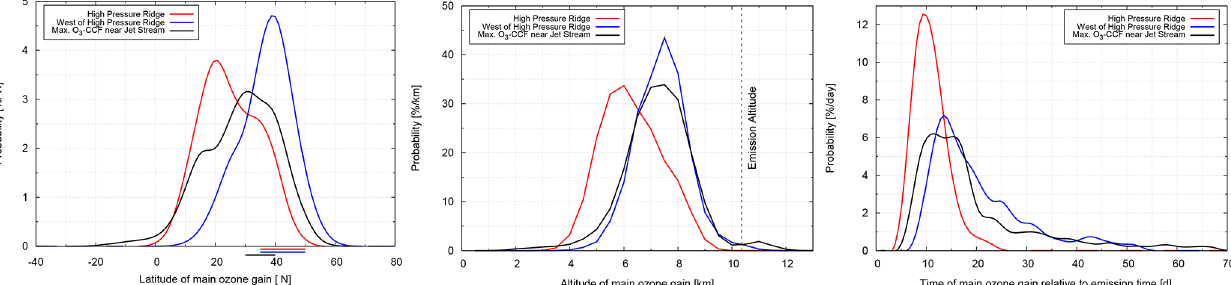
Figure 10. Weighted probability density function of the main ozone gain latitude (left), altitude (middle), and time (right) for three different regions: in the high-pressure ridge (red), west of the high-pressure ridge (blue), and in the area of large O 3 CCF values near the jet stream (black) (for information on regions and weighting, see Appendix A, Table A1, and black dots in Fig. 2). The location of emission release is indicated by